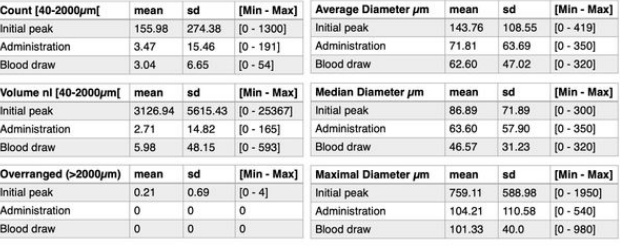
Figure 2: Summary of the composition of all analysed bubble count peaks in the arterial cannula, categorized by peak